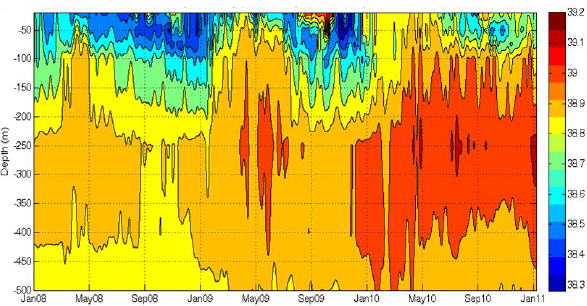
Fig. 11. Time-series plot of lithogenic content and flux, and aerosol optical depth at 550nm. Analyses of aerosol optical depth used in this plot were produced with the Giovanni online data system, de- veloped and maintained by the NASA GES